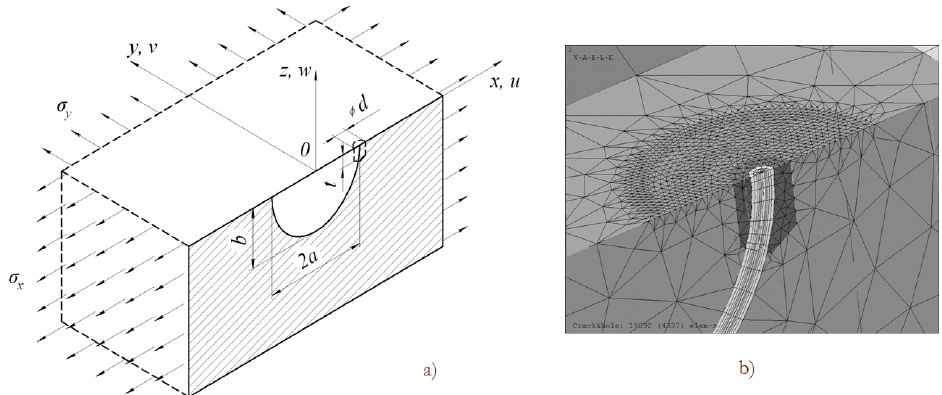
Figure 1: The elastic half-space with a semi-elliptical crack and a probe hole (a) and finite element model of the output crack on the surface (b).